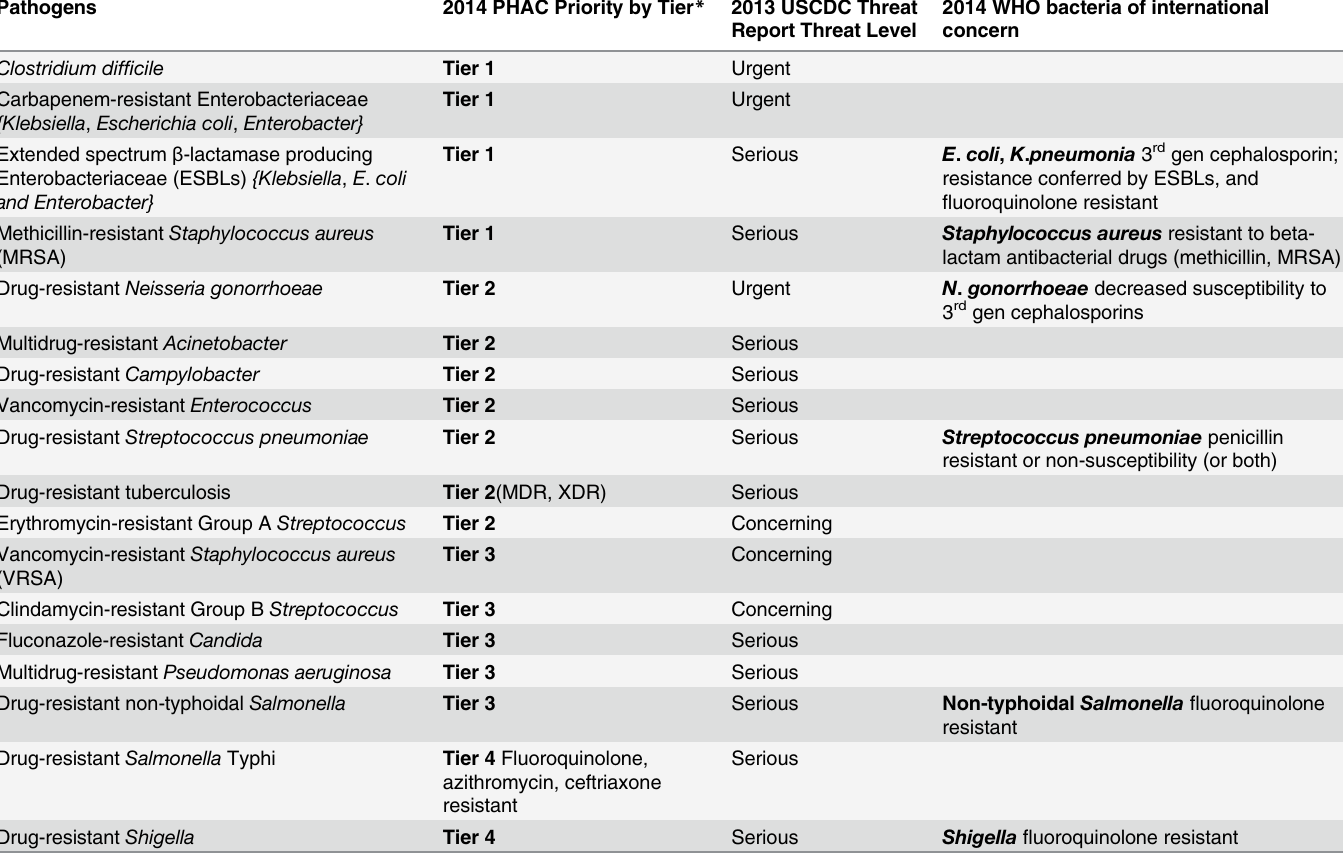
Table 3. Comparison of pathogens from PHAC Prioritisation, the CDC Threat Report [2] and the WHO bacteria of international concern